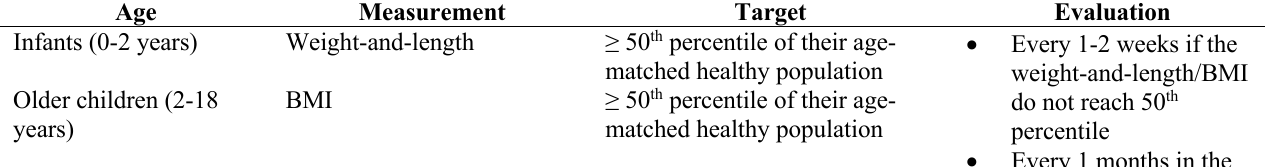
Table 3. The nutritional status goal in CF patient 11